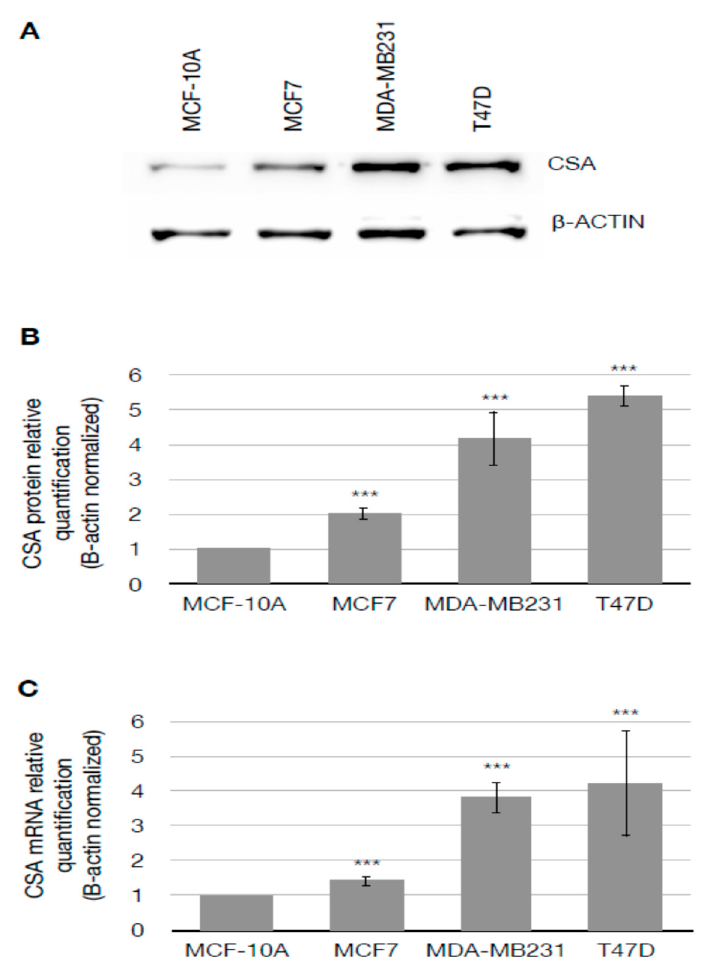
Figure 1. ( A ) Western Blotting showing CSA protein and β -Actin levels. β -Actin was used as loading control; Original blots see Supplementary File S1. ( B ) Graph showing CSA relative amount β -Actin normalized; ( C ) qRT-PCR analysis of CSA mRNA expression. Data are presented as means ± SD of three independent experiments. *** is for p < 0.001 calculated with Student’s T